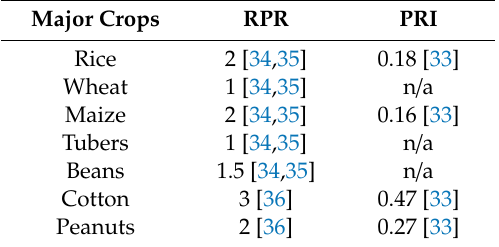
Table 1. Residue to Product Ratio (RPR) and Process Residue Index (PRI) for major crops in Beijing. Major Crops RPR PRI Rice 2 [34,35] 0.18 [33] Wheat n / a Maize